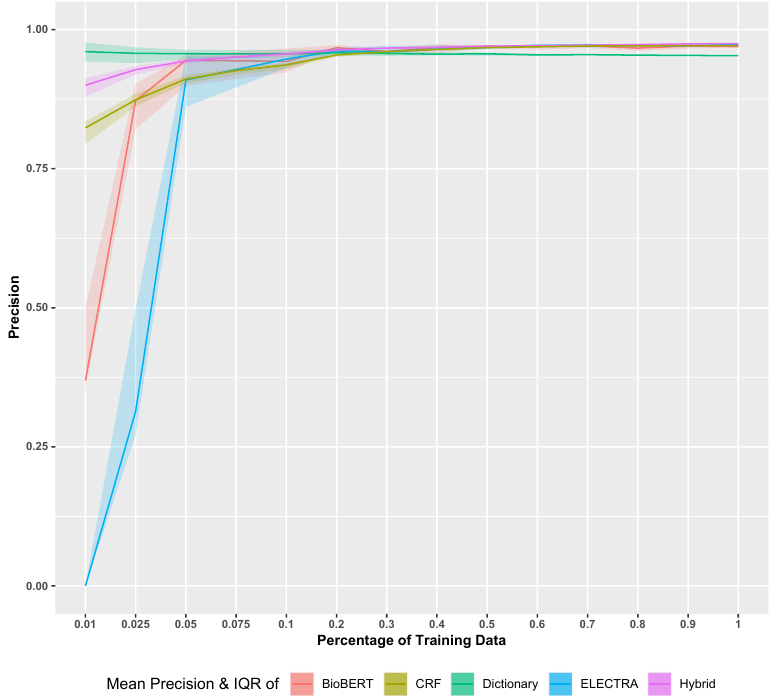
Figure 6. Learning curves based on precision for the dictionary model, CRF model, hybrid model, BioBERT model and ELECTRA model. The line represents the mean F-score and the shaded area represents the inter-quartile range